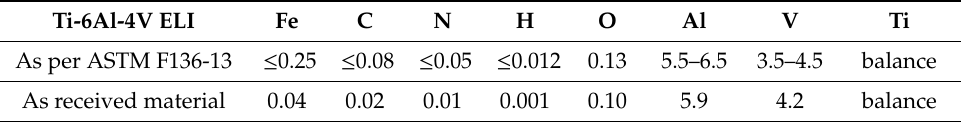
Table 1. Chemical composition (wt %) of Ti-6Al-4V ELI alloy.